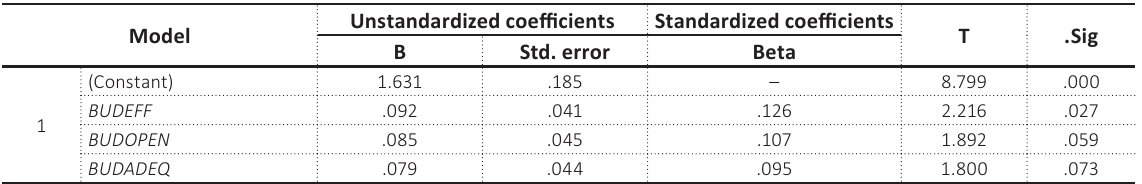
Table 7. Regression analysis of the